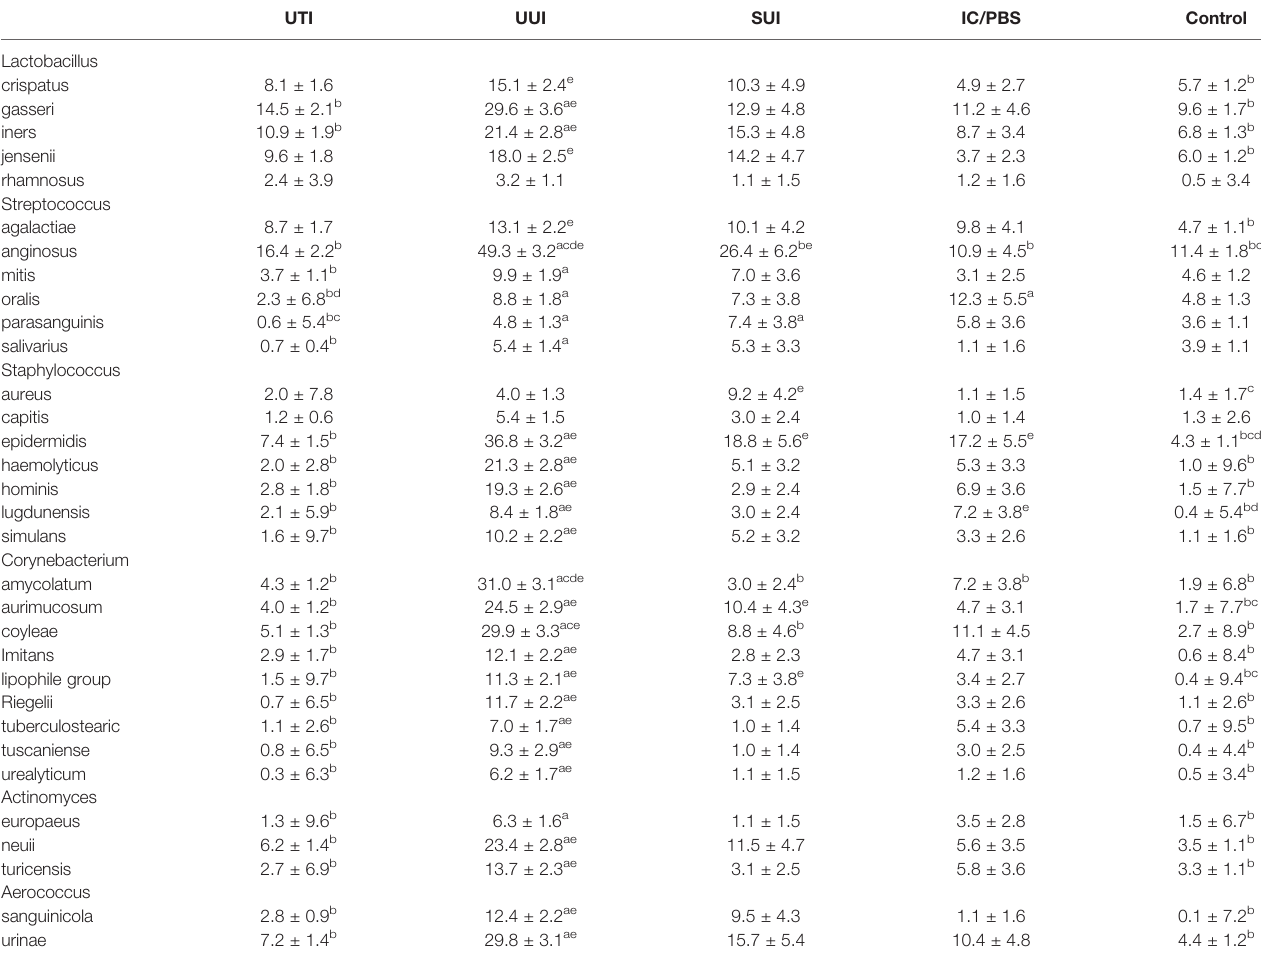
TABLE 5 | Age adjusted prevalence (%) ± standard